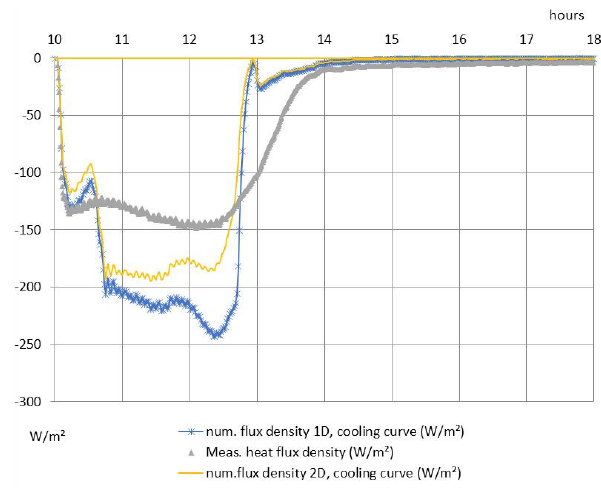
Figure 12. Comparison between 1D and 2D results for heat flux density to container surface. Heating case—cooling heat capacity curve.